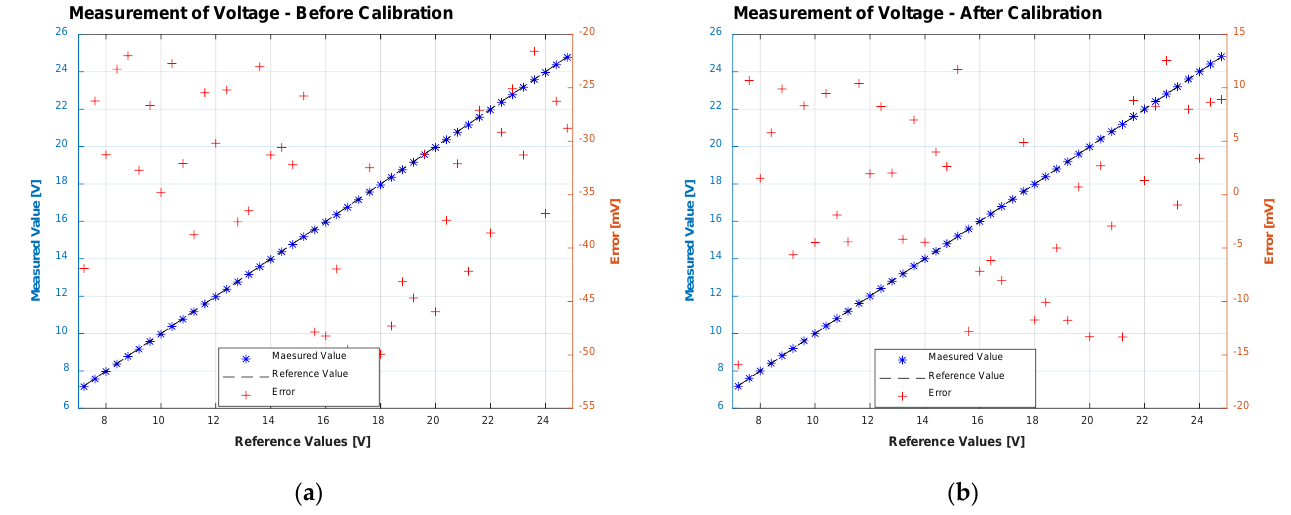
Figure 18. Measurement of Voltage: ( a ) Before Calibration; ( b ) After Calibration.